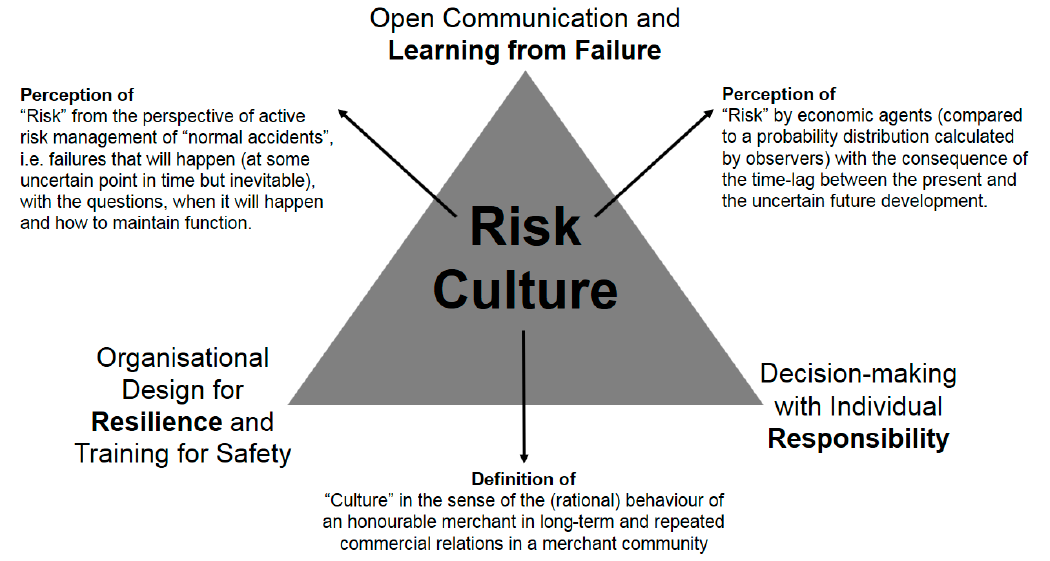
Figure 1. A schematic representation of a “risk culture” starting with the indicated perceptions of “risk” (as seen from different perspectives) and definition of “culture” and three basic elements in the corners: learning from failure, resilience, and individual responsibility.